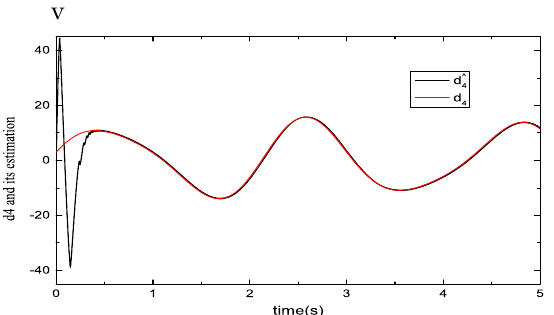
Figure 5. Performance evaluation curves for four unknown disturbance observers: disturbance of motor 4 and its estimated